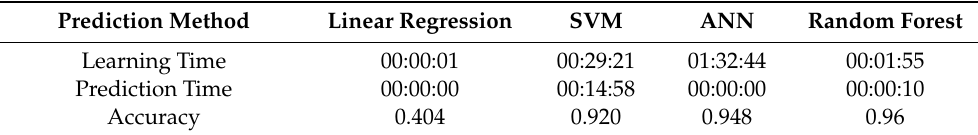
Table 12. Comparison of model performance by prediction